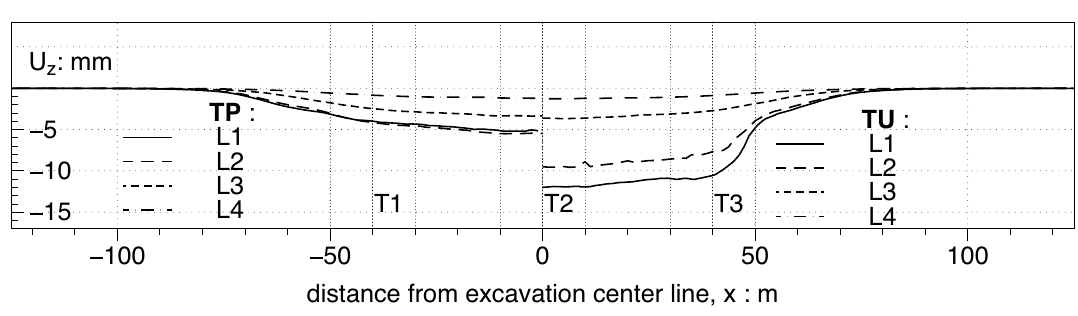
Figure 10. Displacements along sections normal to the wall: ( a ) analyses TU; ( b ) analyses TP.